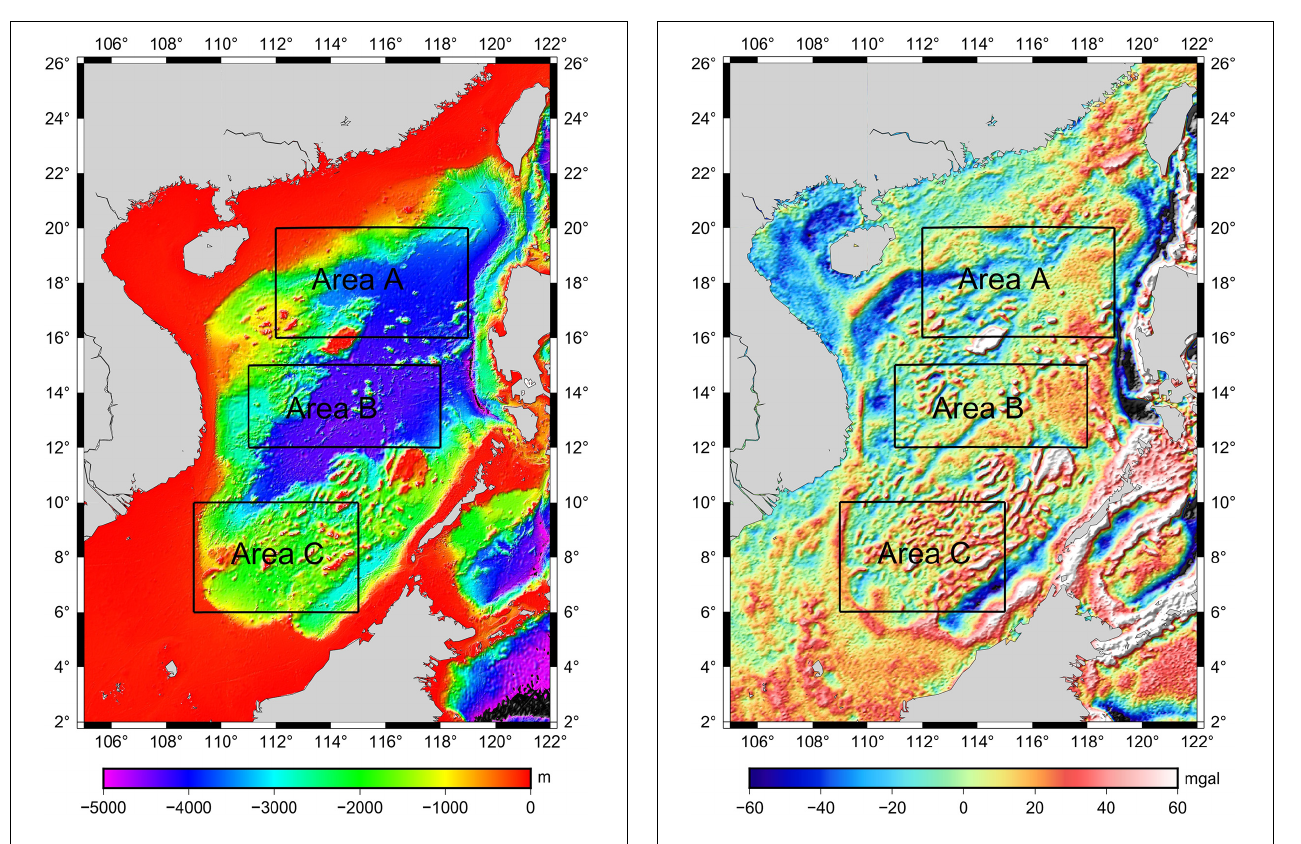
FIGURE 2 | Seafloor topography of the SCS. Locations of the test areas (Areas A, B, and C) are shown in the background map of GEBCO 2020 bathymetry model.